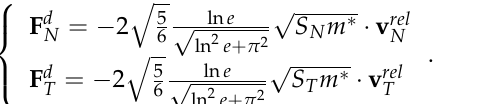
Normal damping force F d tion during collision, which are expressed in Equation (6):